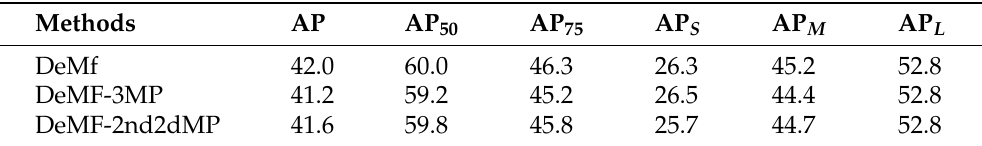
Table 9. Results of DeMF with different architectures on COCO val2017 set. ‘DeMF-3MP’ denotes adding an extra third max pooling stream with the same pipeline as the second one. ‘DeMF-2nd2dMP’ represents replacing the 3D max pooling operation in the second max pooling stream with a 2D max pooling.